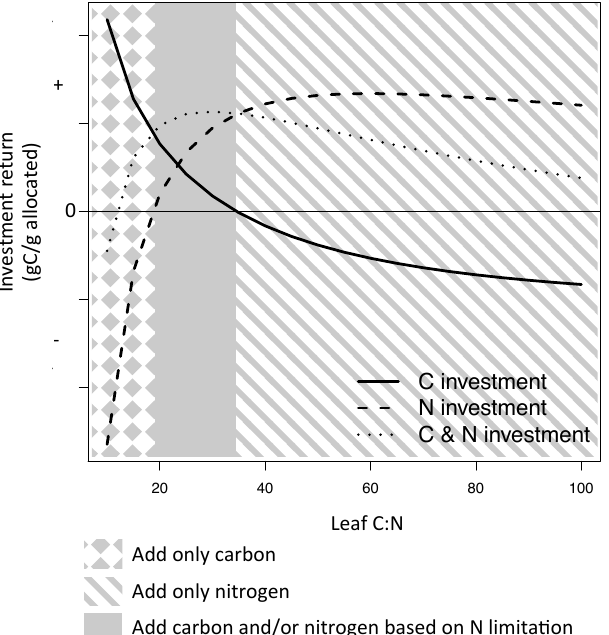
Figure 2. A schematic illustrating the adjustment of leaf C:N for a given leaf area index using the marginal C returns on investment of leaf C and leaf N. At low leaf C:N, leaf N has a negative return and leaf C has a positive return on investment that results in allocation to increase the leaf C : N (diamond shading). At high leaf C : N, leaf N has a positive return and leaf C has a negative return that results in allocation to decrease the leaf C:N (hashed shading). At inter- mediate leaf C:N, allocation of both leaf C and N are positive and allocation adjustments reflects where tissue growth is limited by N